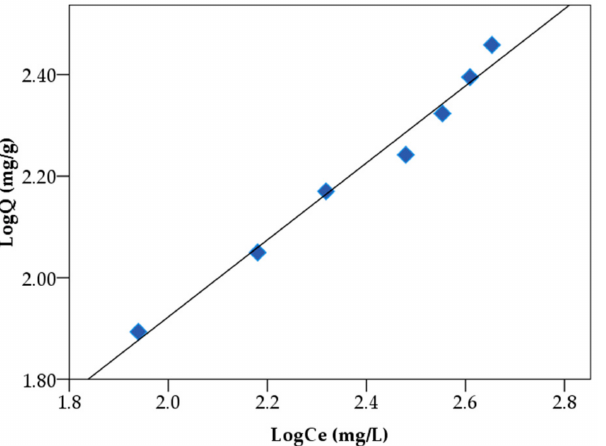
Figure 6. Freundlich plot of copper ions on ion-imprinted polymer. Linear equation y = 0.758 x + 0.407, R 2 =